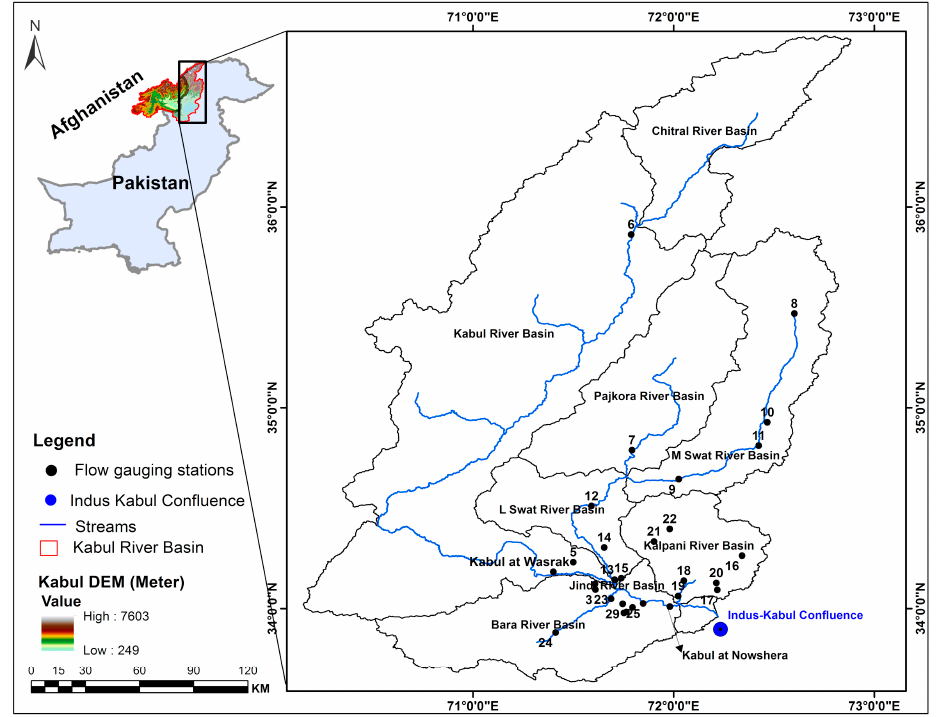
Figure 1. Description of Location, SRTM-DEM (Shuttle Radar Topography Mission–digital elevation model, meters) and flow gauge stations for the Kabul River basin (KRB), Pakistan.